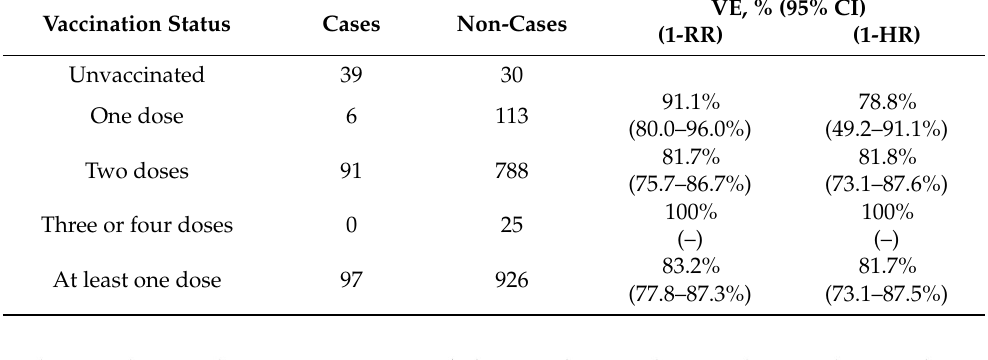
Table 1. Cases distribution of the medical center’s employers, depending on the vaccination status during Delta dominance period (1 May–30 November 2021).